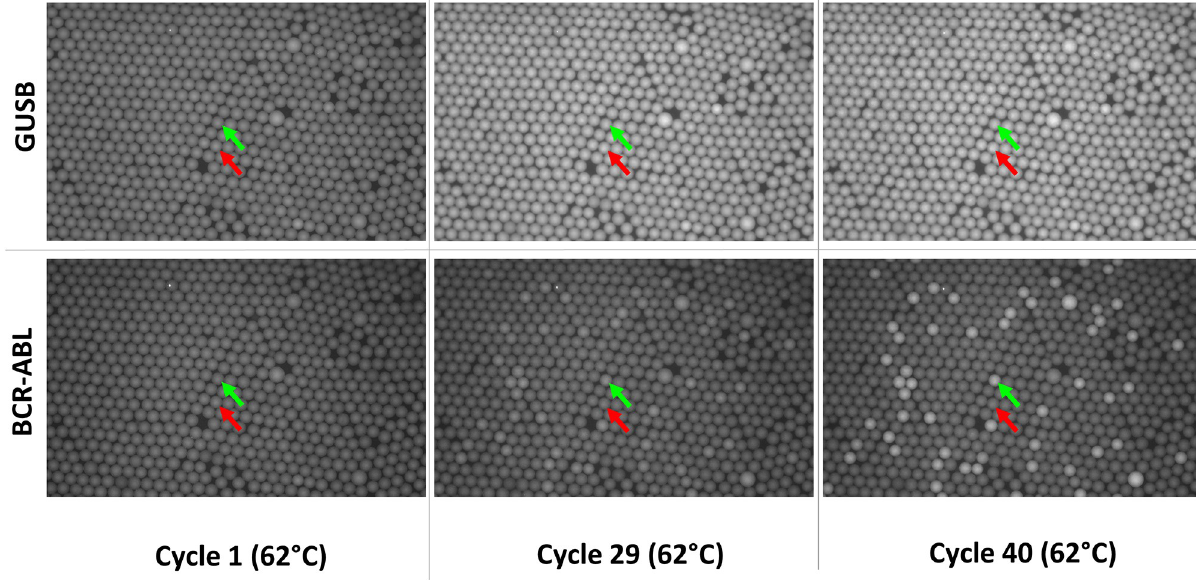
Fig 3. Fluorescence Images from real time PCR analysis. Fluorescence images after one, twenty-nine and forty cycles for the GUSB and BCR-ABL1 specific channels (FAM for GUSB, upper row; Cy5 for BCR-ABL1, lower row). Green arrows, one arbitrarily selected BCR-ABL1 positive and GUSB positive nanoreactor bead; Red arrows, a nanoreactor bead negative for BCR-ABL1 and positive for GUSB.